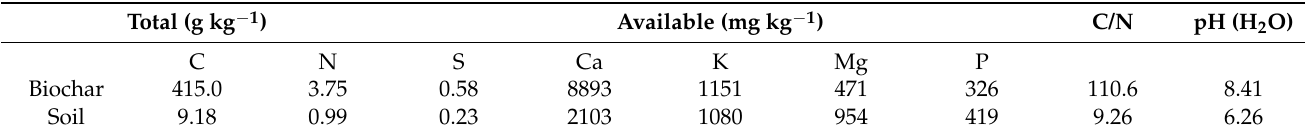
Table 1. Soil and biochar